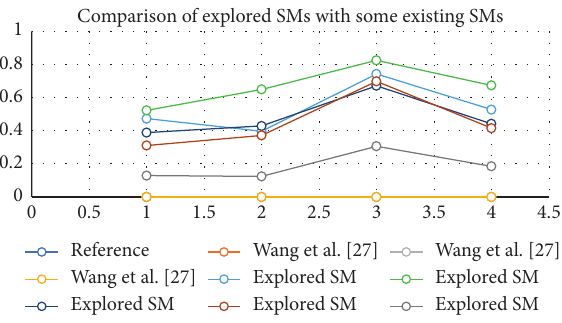
Figure 6: The graphical portrayal of the comparison of proposed and existing SMs for Example